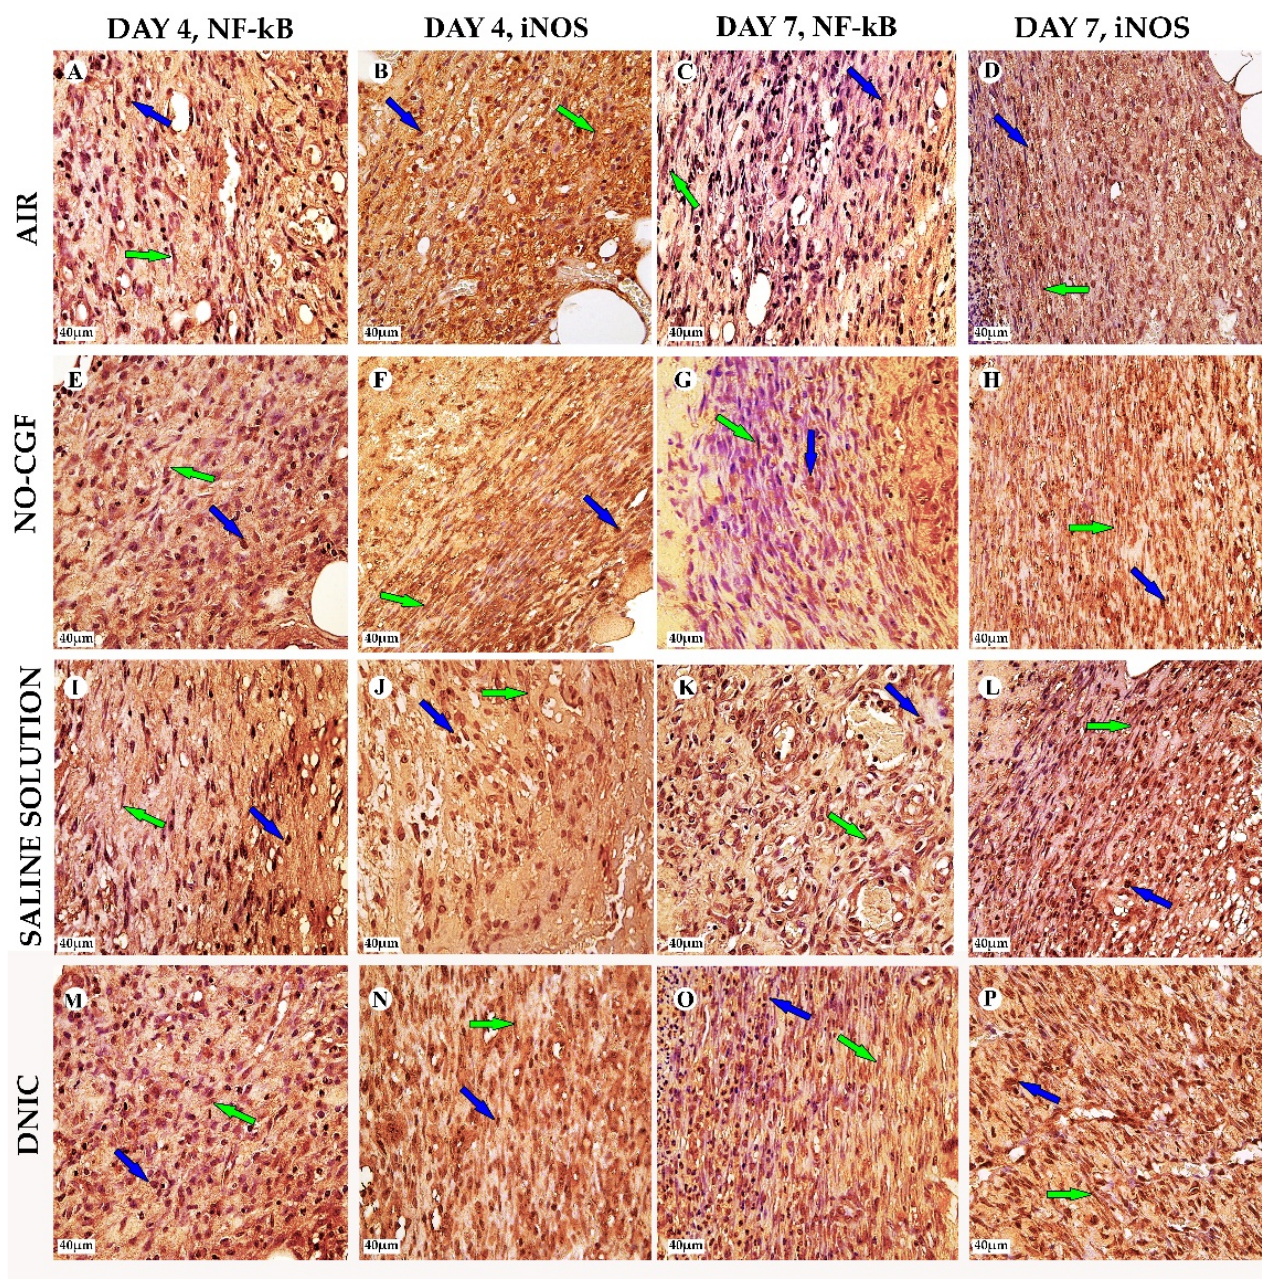
Figure 4. NF- κ ß ( A , B , E , F , I , J , M , N ) and iNOS ( C , D , G , H , K , L , O , P ) expression in the study groups on days 4 and 7, magnification ×400. Green arrow—fibroblast, blue—macrophage. ( A ) NF- κ ß cytoplas- mic expression in macrophages, ( B ) iNOS expression in fibroblasts of immature granulation tissue, ( C ) weak cytoplasmic expression of NF- κβ in fibroblasts, ( D ) iNOS-positive cells in the superficial part of wound, ( E ) intensive nuclear NF- κ ß expression in macrophages, ( F ) iNOS-positive fibroblasts in the deep layers of wounds, ( G ) NF- κβ expression in fibroblasts, ( H ) parallel orientated iNOS-positive fibroblasts, ( I ) weak NF- κ ß-positive cytoplasmic expression, ( J ) iNOS expression in macrophages, ( K ) NF- κ ß nuclear expression in chaotically oriented cells, ( L ) intensive iNOS expression, ( M ) prevalence of cells with nuclear expression, ( N ) intensive diffuse iNOS expression, ( O ) intensive NF ‐κβ cytoplasmic expression in fibroblasts and ( P ) numerous iNOS ‐ positive macro ‐ phages.